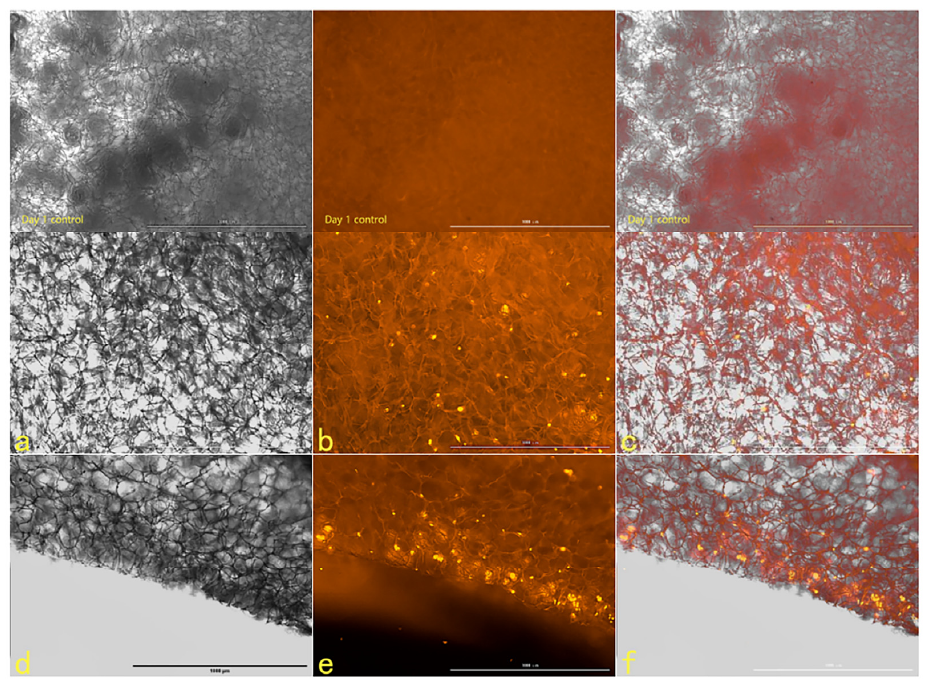
Figure 14. The scanning electron microscope view of chitosan demethylcellulose sodium stent.